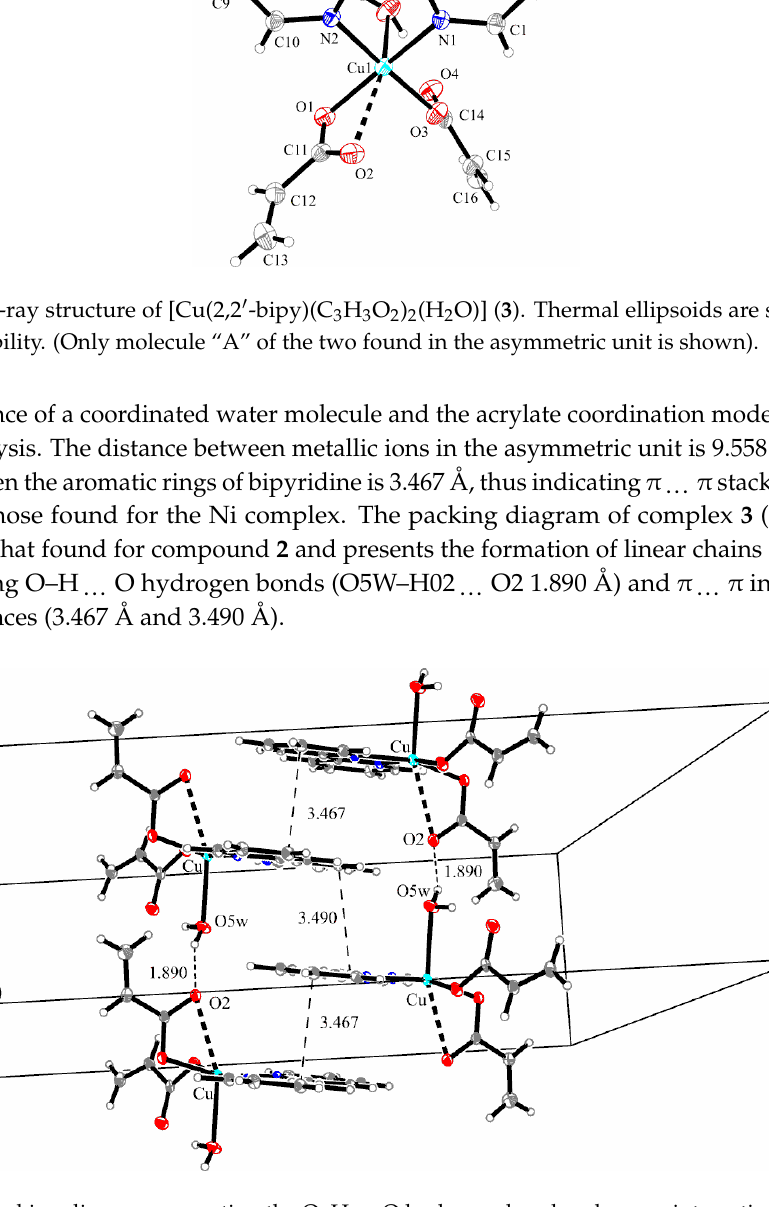
Figure 6. Packing diagram presenting the O–H … O hydrogen bond and π … π interactions along the b -axis in complex ( 3 ).